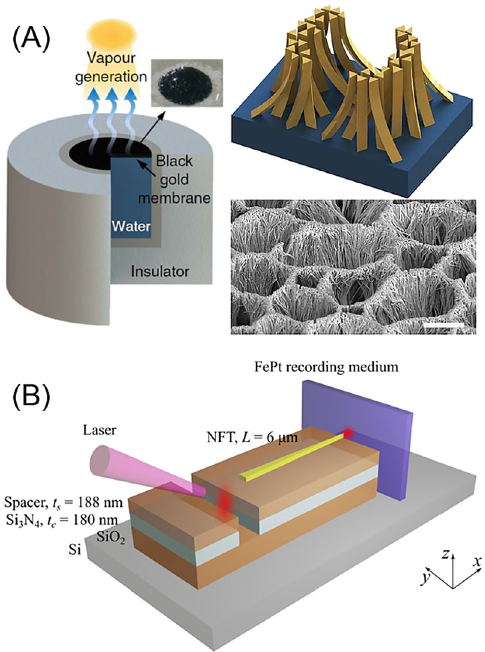
utilizes nanofocusing to generate steam at the apex of